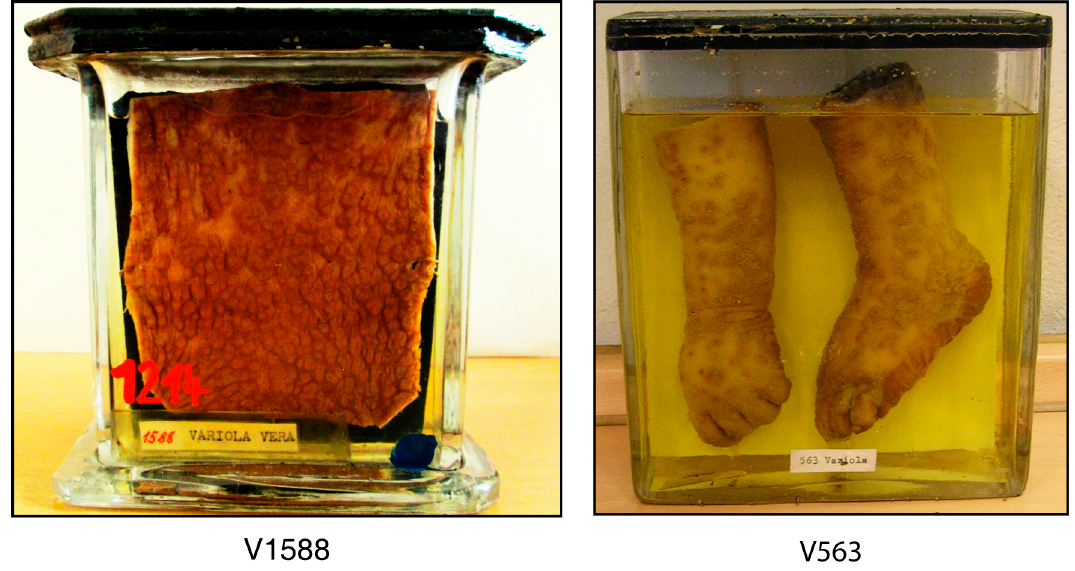
Figure 1. Anatomical specimens V1588 and V563 labeled “Variola”, Czech National Museum,